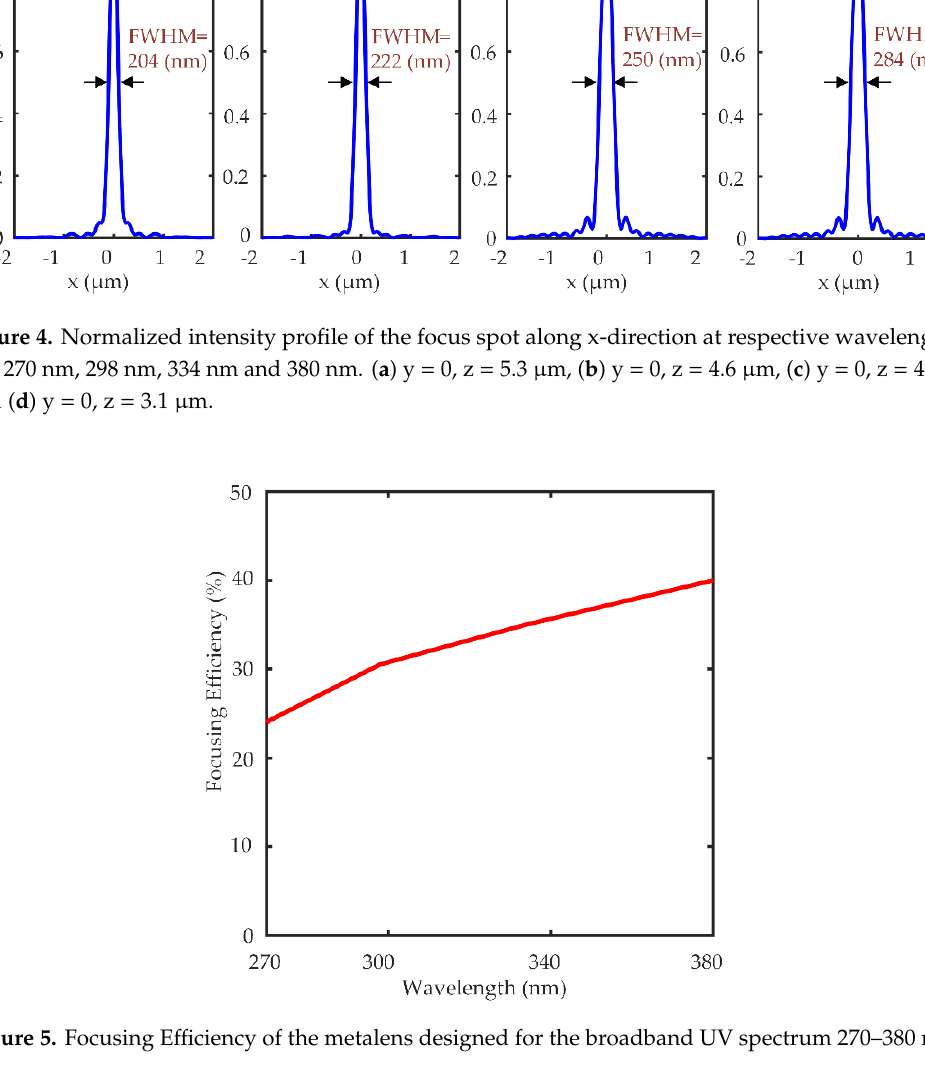
Figure 5. Focusing Efficiency of the metalens designed for the broadband UV spectrum 270–380 nm. Table 1. Summary of our results and other Table 1. Summary of our results and other references.